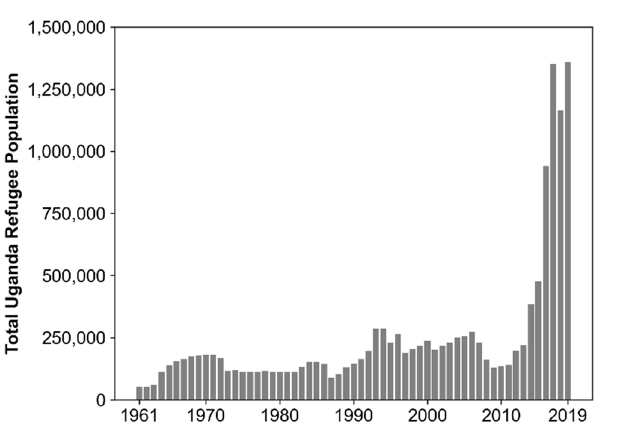
Figure 2. Total refugee population in Uganda from 1961 to 2019. Data from United Nations High Commissioner for Refugees (UNHCR) PopStats, www.unhcr.org/refugee-statistics/down- load/?url=C06z (accessed on 1 December 2020).